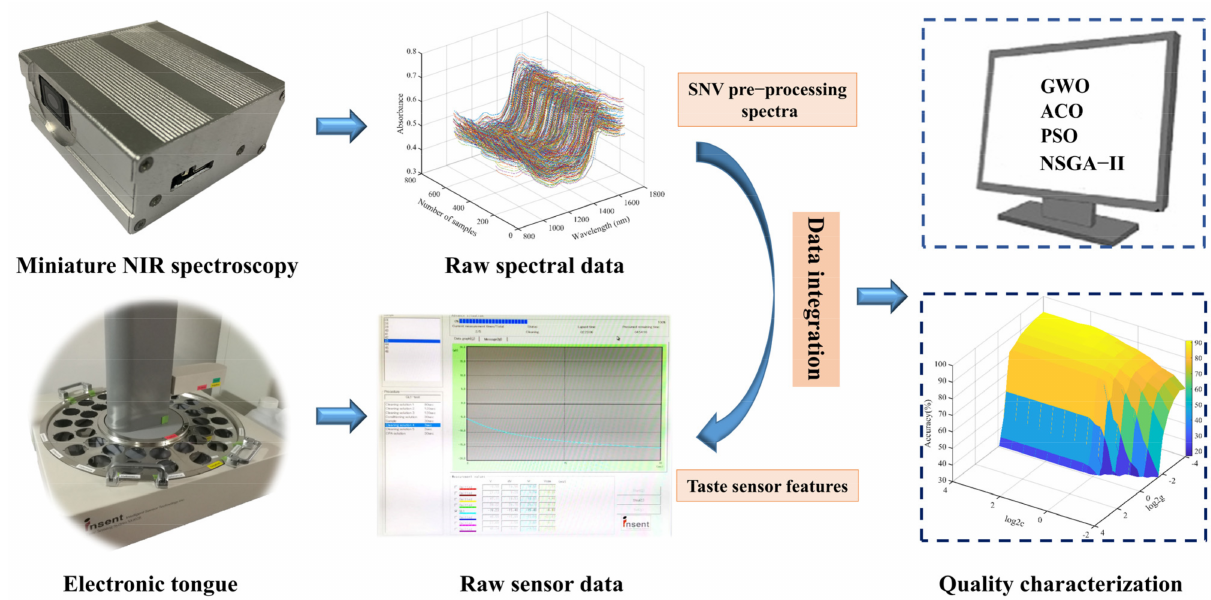
Figure 1. Description of the experimental flow